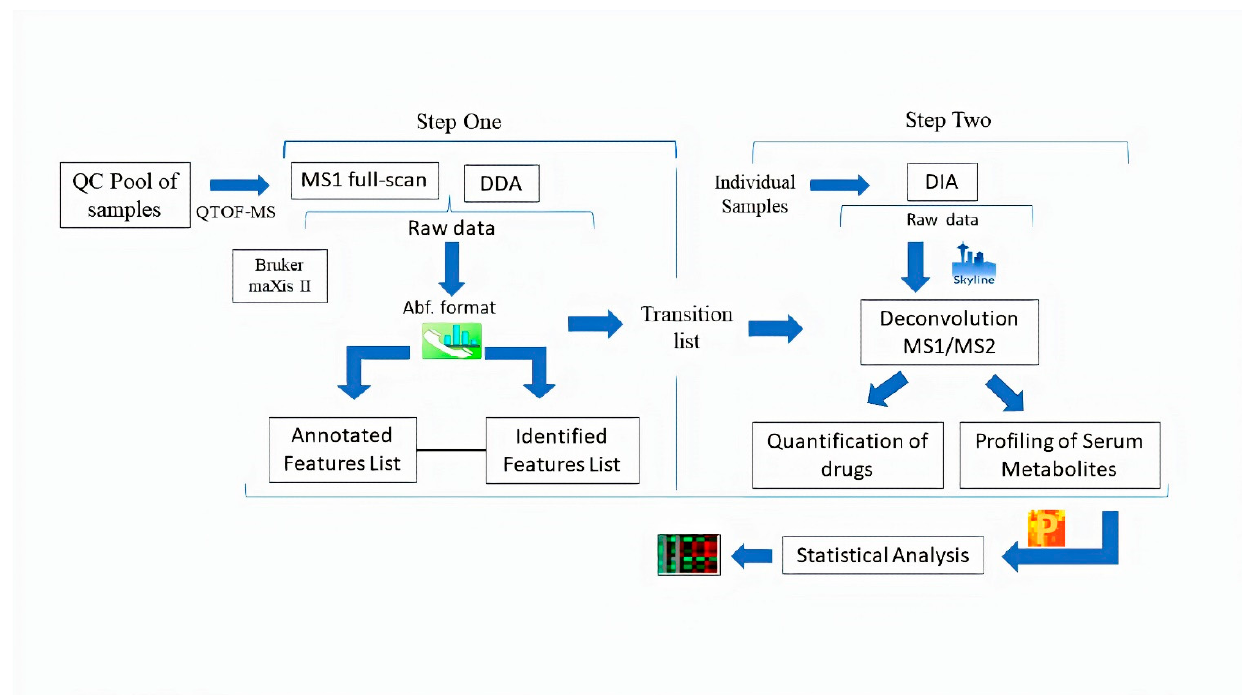
Figure 1. Schematic illustration of the workflow used in this study.